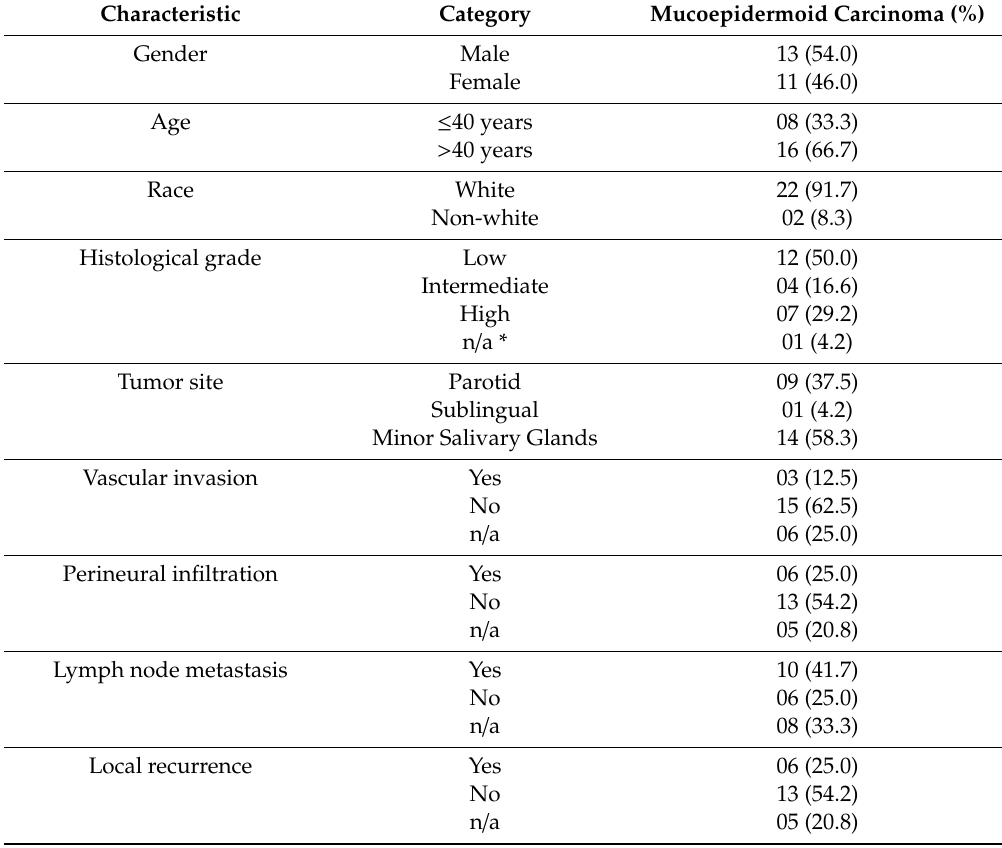
Table 2. Summary of demographic, clinical, and pathological characteristics of mucoepidermoid carcinoma patients.